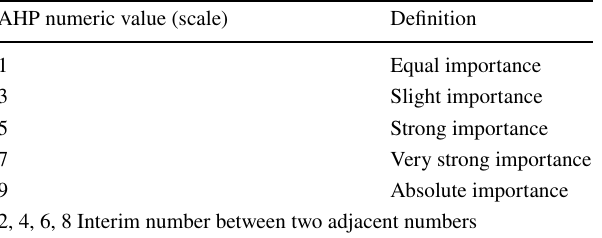
Table 2 The one-to-nine scale of parameters significance (Saaty